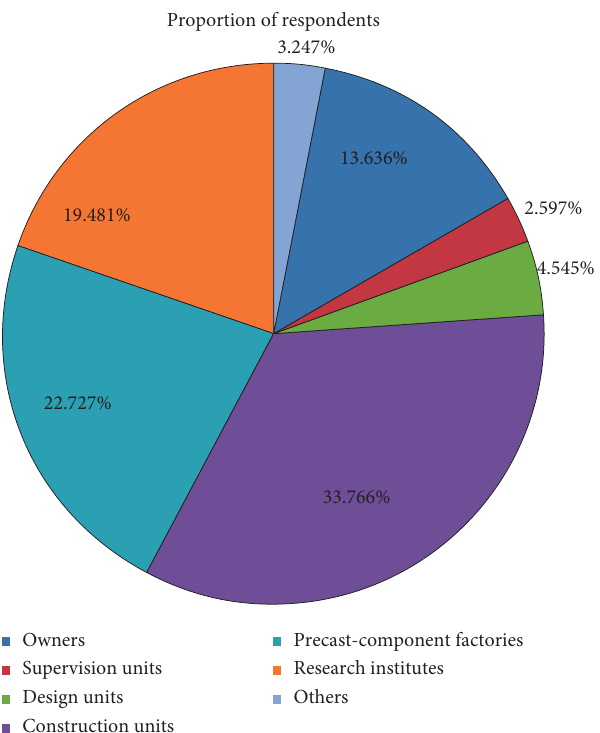
Figure 2: Distribution information of respondents’ work units.